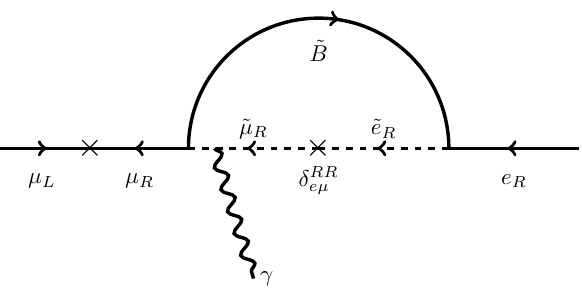
Figure 1. The minimal one-loop contribution to the µ → eγ dipole associated with the flavor- violating slepton collider signal of interest. The right-handed selectron and smuon are both relatively light, and contribute to µ → eγ through a loop involving a bino and the off-diagonal slepton mass matrix contribution δ RR eµ